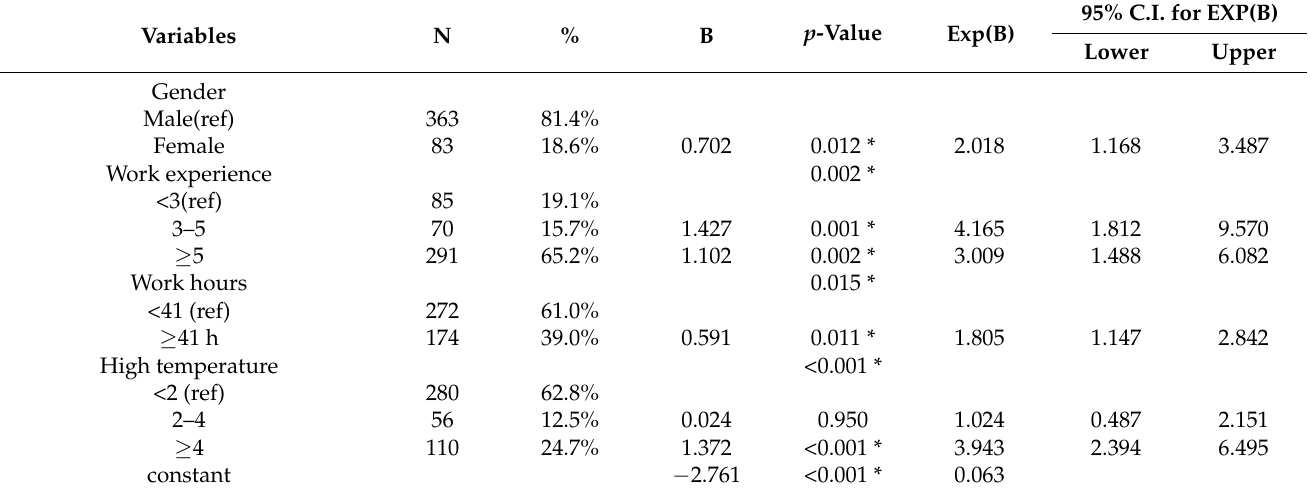
Table 15. Results of logistic regression on pain complaints in any one